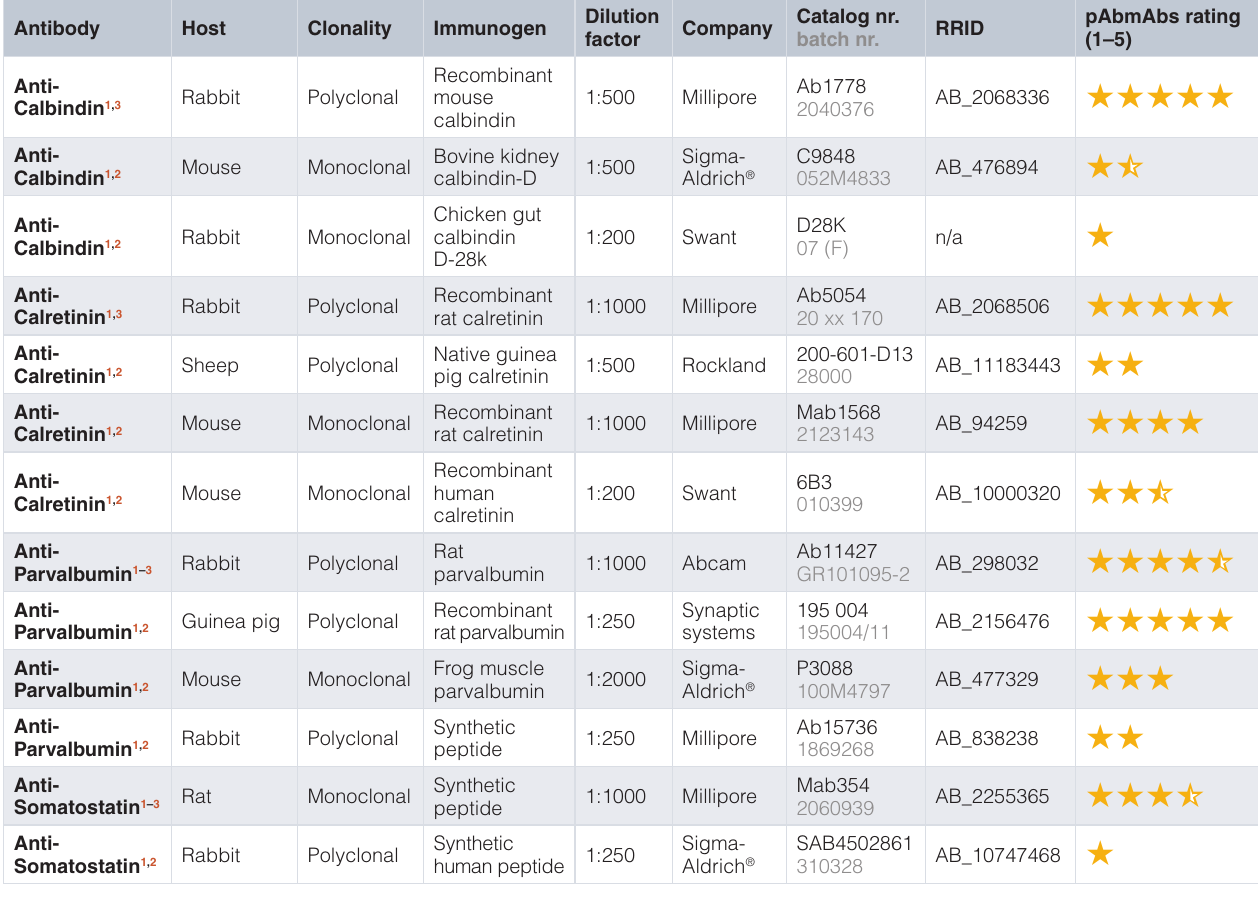
Table 2. Primary antibodies used for immunostaining of 1 hippocampal sections, 2 hippocampal neurons and 3 spinal cord sections. The pAbmAbs rating reflects the average rating of the antibodies as of October 2014.